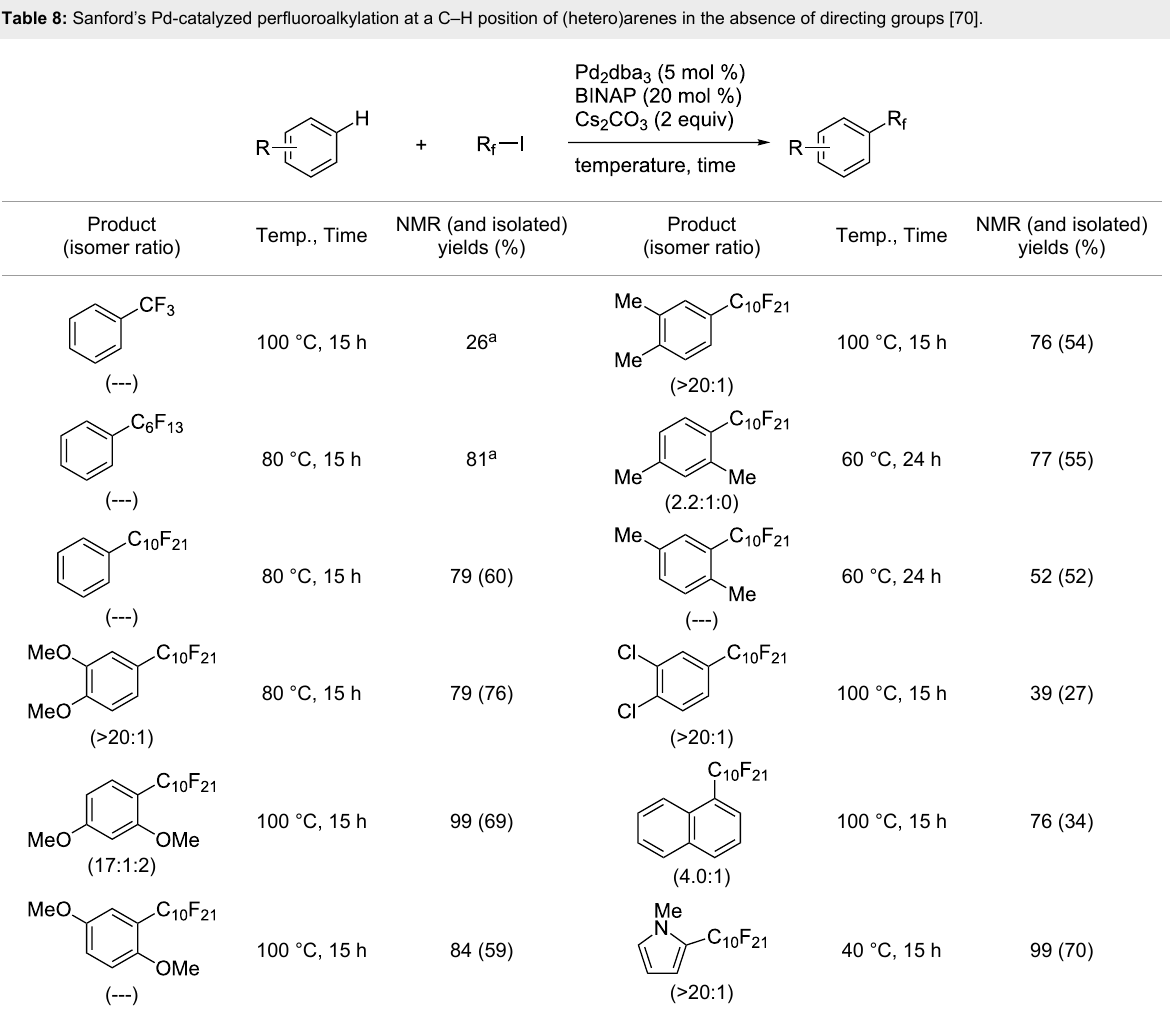
Table 8: Sanford’s Pd-catalyzed perfluoroalkylation at a C–H position of (hetero)arenes in the absence of directing groups [70].